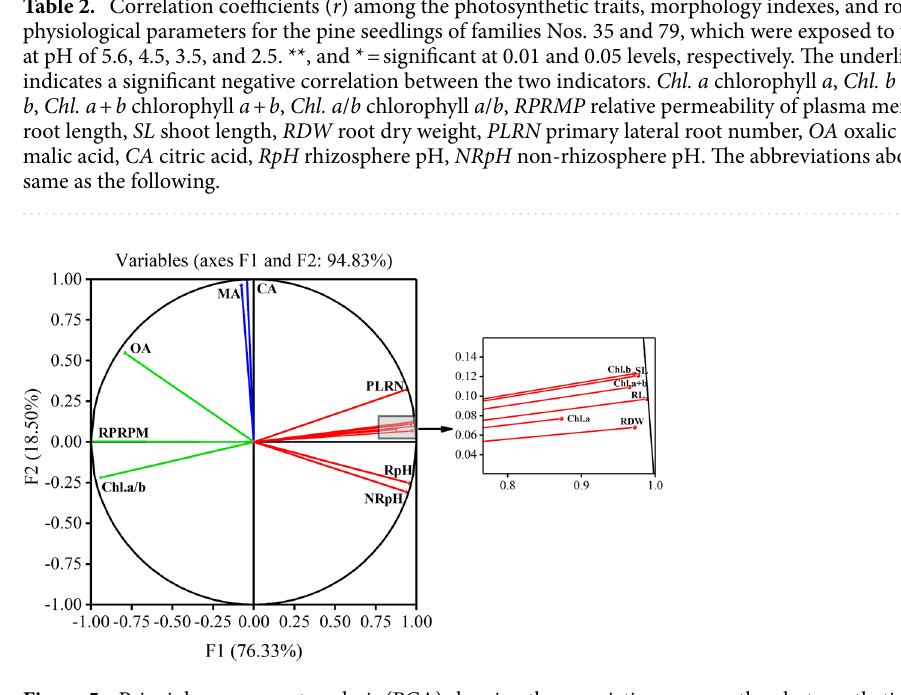
Figure 5. Principle component analysis (PCA) showing the associations among the photosynthetic traits, morphology indexes, and root physiological parameters of Masson pine families Nos. 35 and